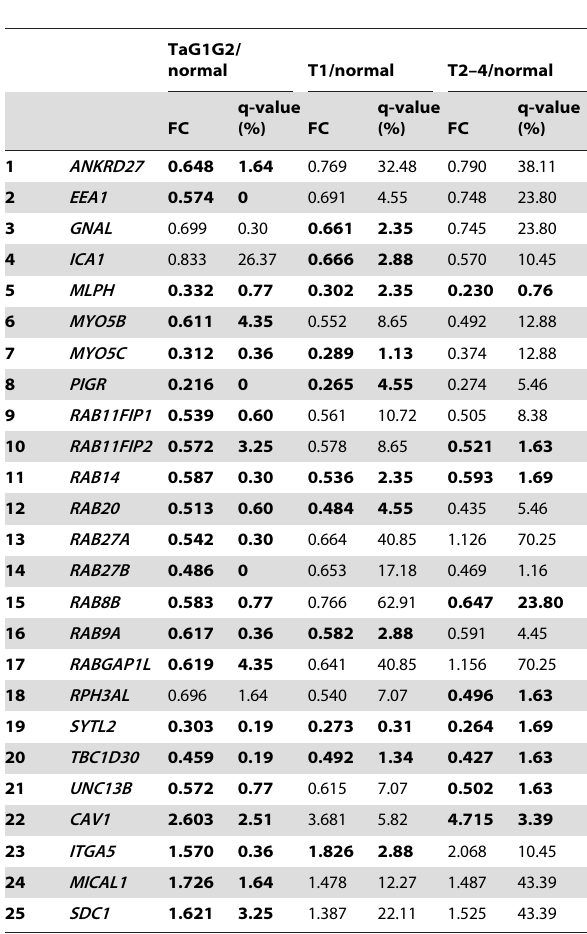
Table 2. Deregulated genes during bladder cancer pathogenesis in the FGFR3 -non-mutated tumor pathway.